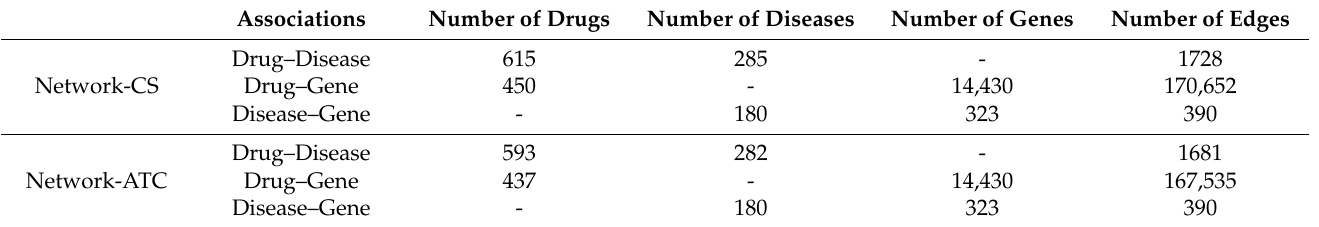
Table 2. Number of distinct drugs, diseases, genes, and edges in the tripartite graph created based on the associations between different types of nodes in the